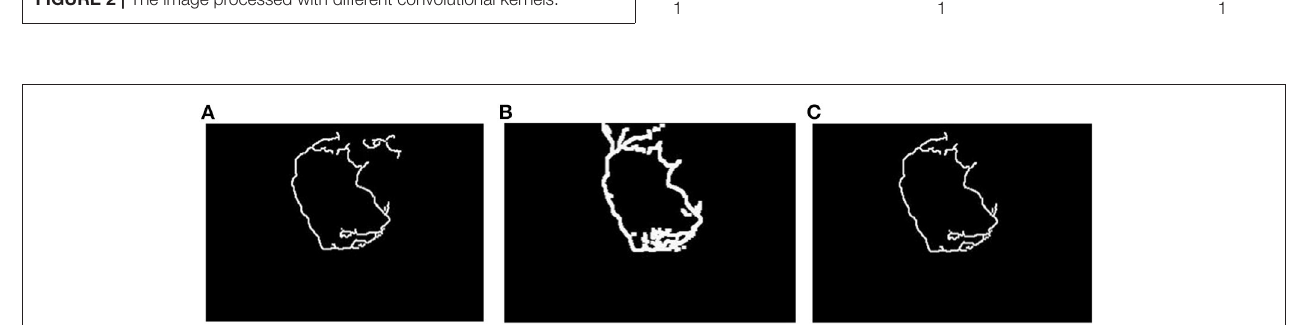
FIGURE 2 | The image processed with different convolutional kernels.